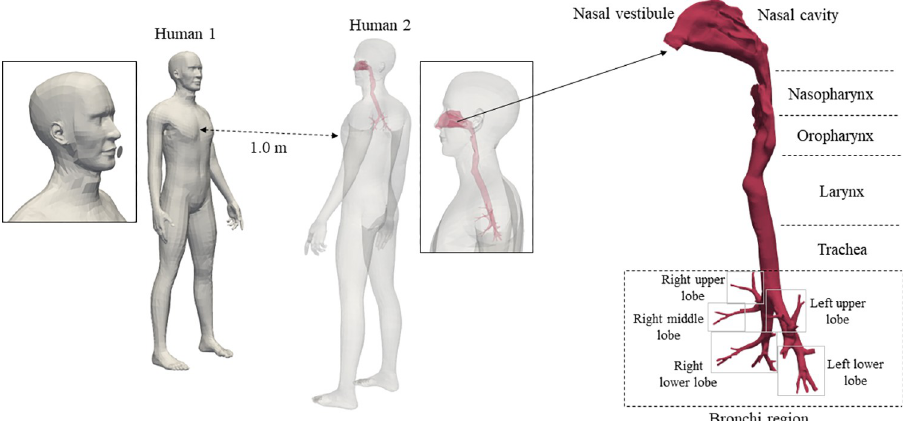
Fig 1. Design of analyzed domain with respiratory tract divisions